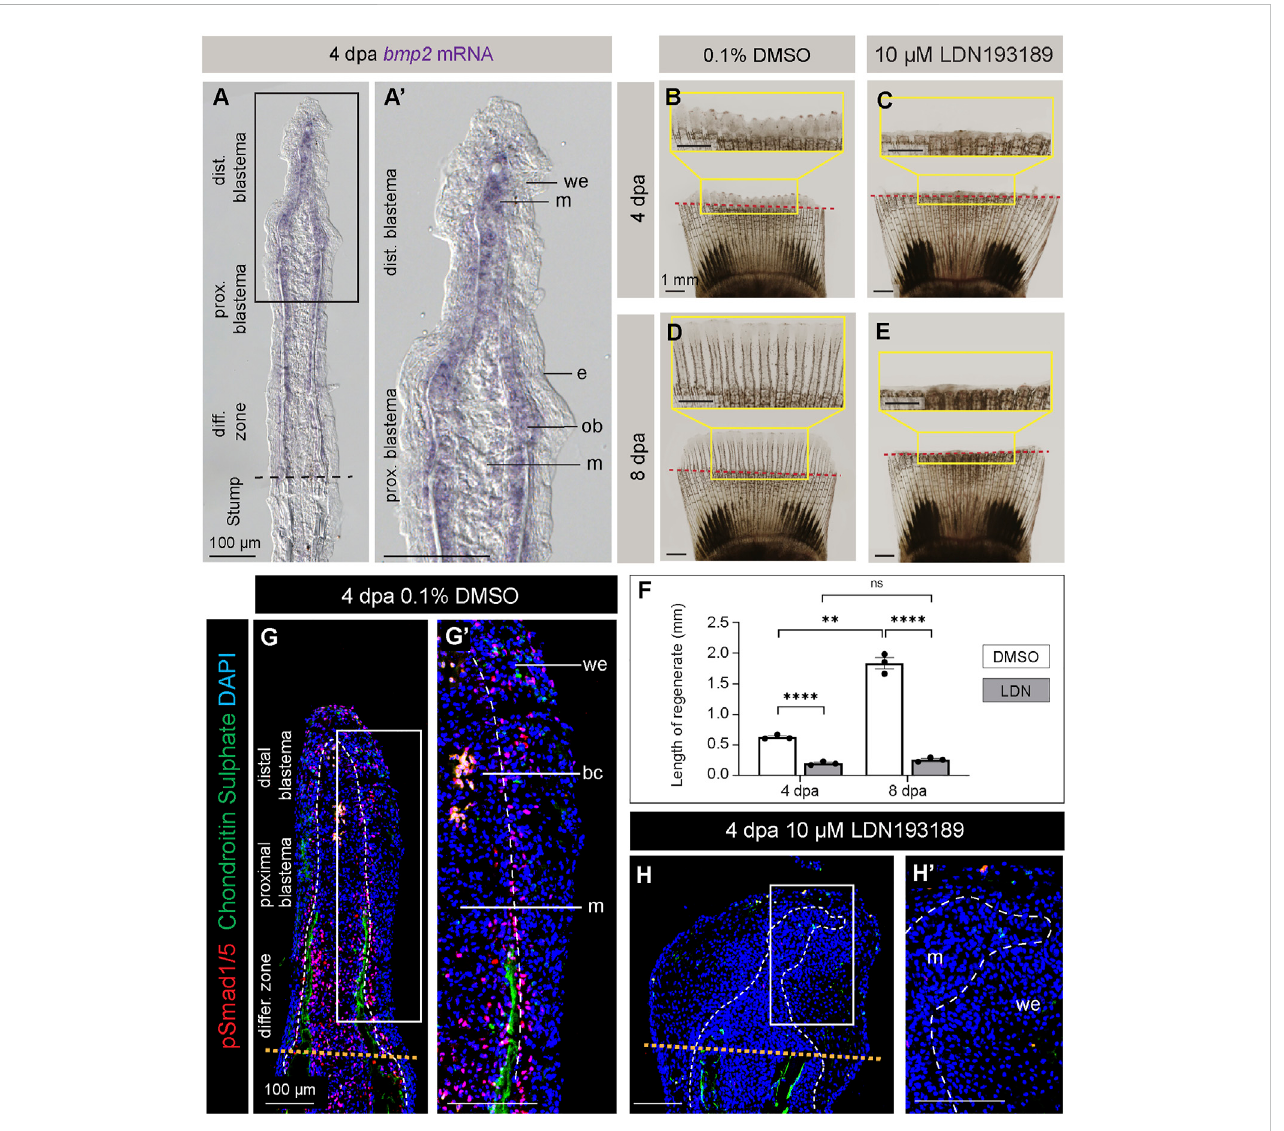
Inhibition of BMP signaling impairs fi n regeneration in platy fi sh. (A, A 9 ) In situ hybridization of the platy fi sh bmp2 gene on fi n sections at 4 dpa. (B – E) Live imagingofplaty fi sh fi nstreatedwith either0.1%DMSOcontrolortheBMP inhibitor,LDN193189at4and 8 dpa,as indicatedonthe fi gure.Theregenerationis impaired intheLDN193189-treatedgroup of fi sh. (F) Quanti fi cationoftheregeneratelengthsshows no signi fi cant difference between 4 dpa and8 dpainthe inhibitor-treatedgroup, suggesting apersistentblockageofregeneration,andnotmerelyadelay. N=3;average ofthreeraysper fi n; errorbarSEM; n.s., not signi fi cant, p > 0.05; ** p < 0.01; **** p < 0.0001; paired two-tailed Student ’ s t-test for the same fi sh at different time-point; unpaired two-tailed Student ’ s t-test between drug-treated and control fi sh. (G and H) Immuno fl uorescence staining of fi n sections at 4 dpa with antibodies against chondroitin sulphate (green)tovisualizelepidotrichiaandpSmad1/5(red),whichisareadoutofBMPsignaling.Orangedottedlinesdepicttheamputationplane;whitedashedlines underly the basal epithelium. We; wound epidermis; m; mesenchyme; bc, blood clot. N = 3, at least three ray sections per fi